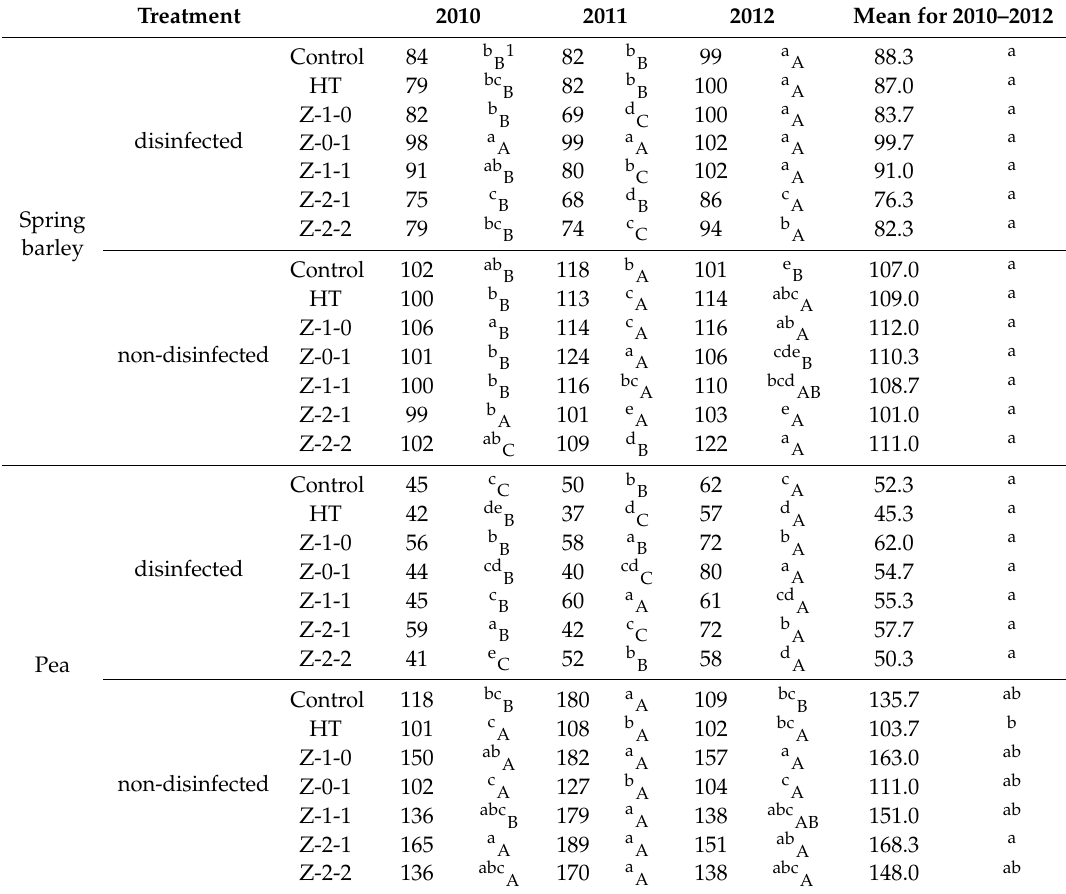
Table 3. The average number of total fungi isolated from disinfected and non-disinfected spring barley and pea grains in 2010–2012 (CFU (Colony Forming Unit) per 100